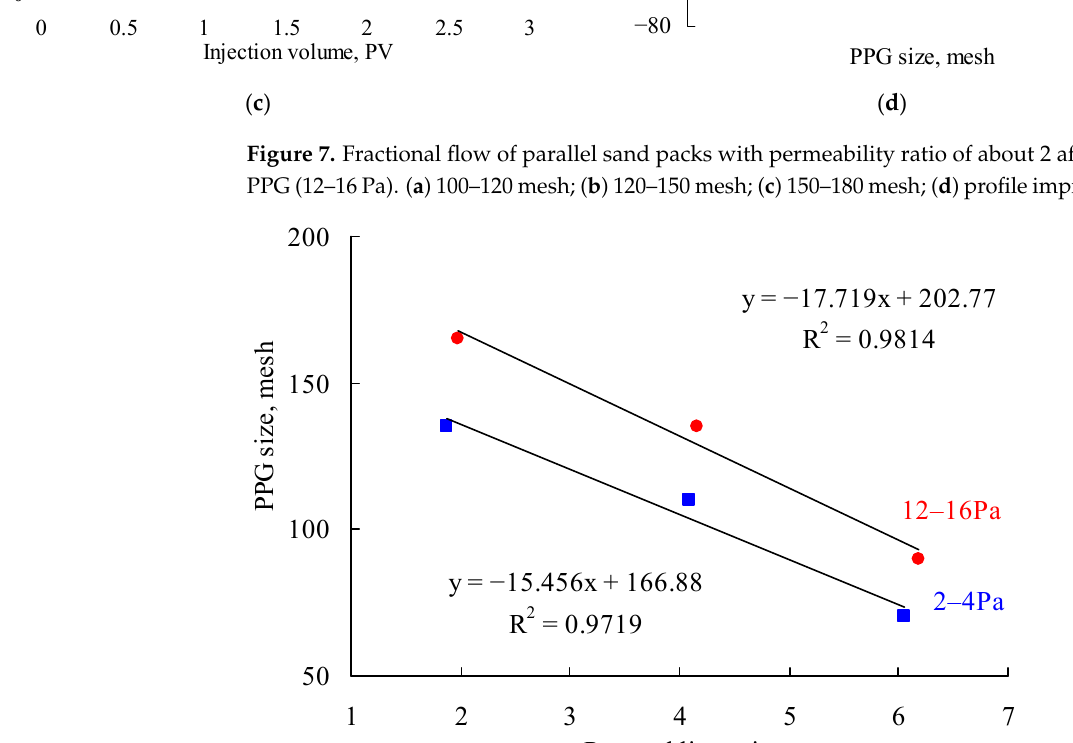
Figure 8. Matching relationship between PPG size, elastic modulus and permeability ratio.